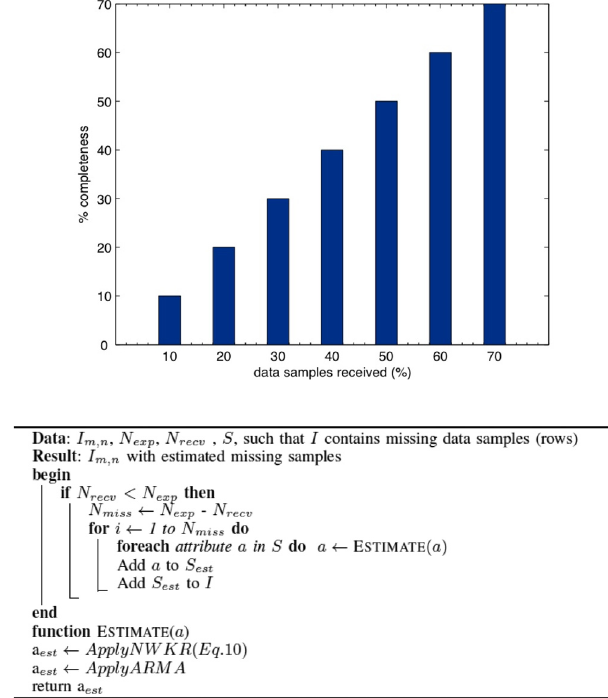
Figure 2. Algorithm: missing data samples(s)